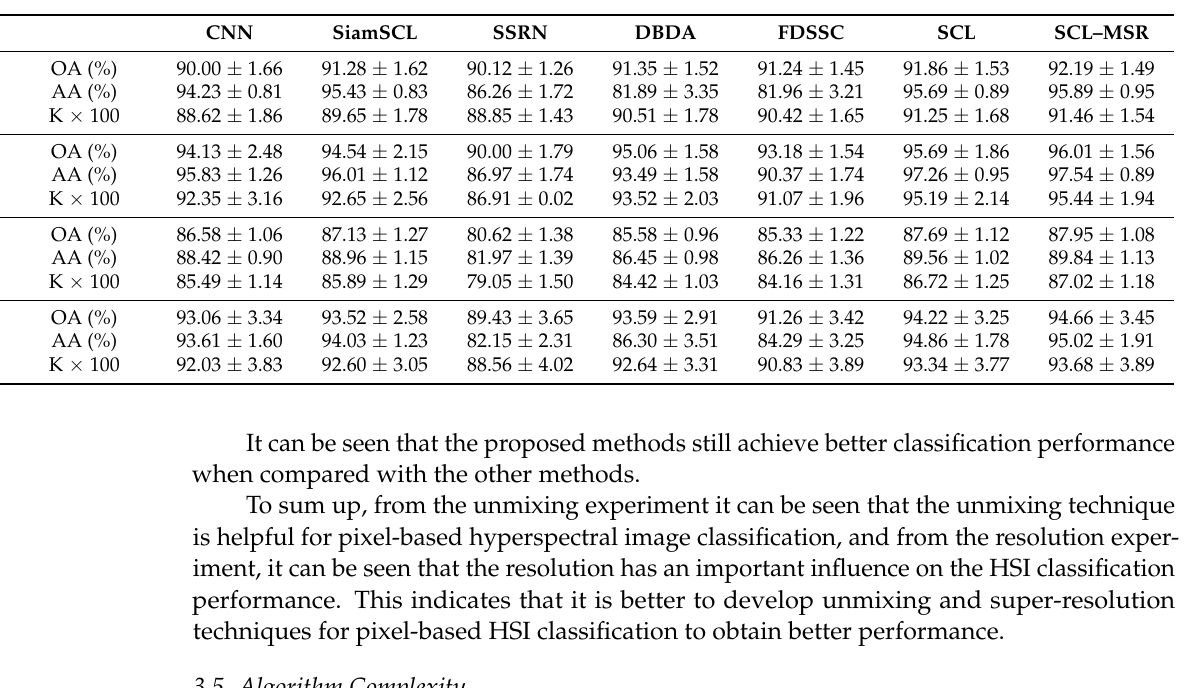
Table 11. Classification results when the spatial resolution is poor.